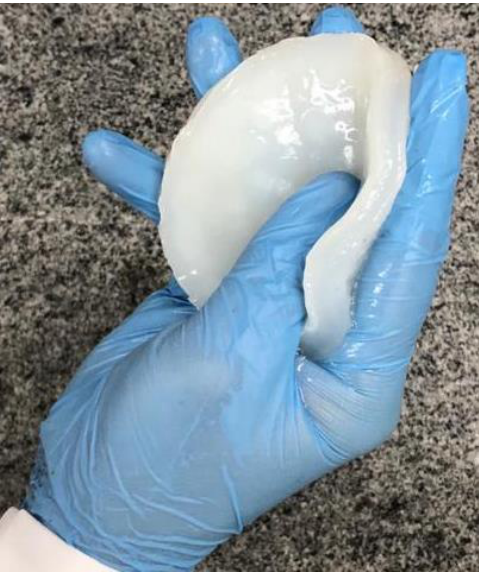
Figure 4. Picture of a bacterial cellulose membrane. Reproduced with permission from [65], Universidade Católica de Pernambuco, 2020.